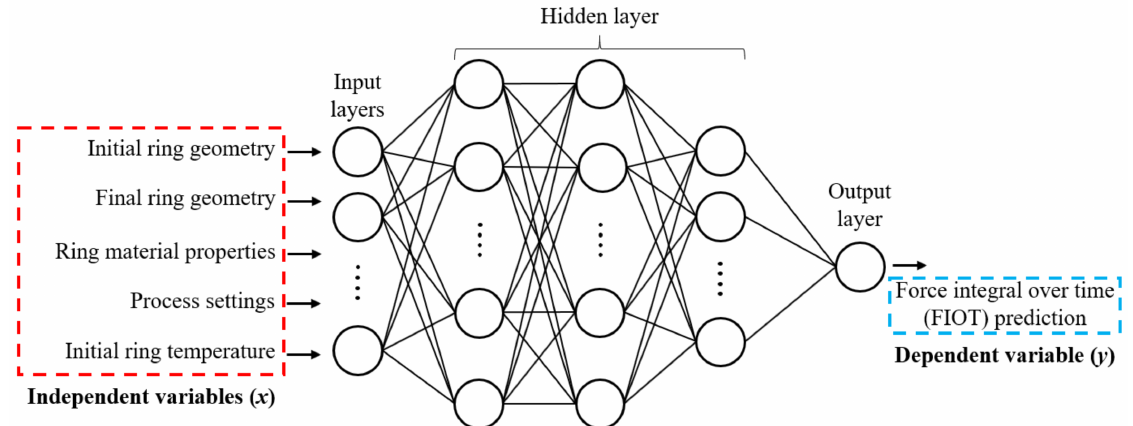
Figure 2. Artificial Neural Network model architecture schematic explaining the connection between input layers (input parameters considered in this research) and output layer, considered as the force integral of mandrel acting